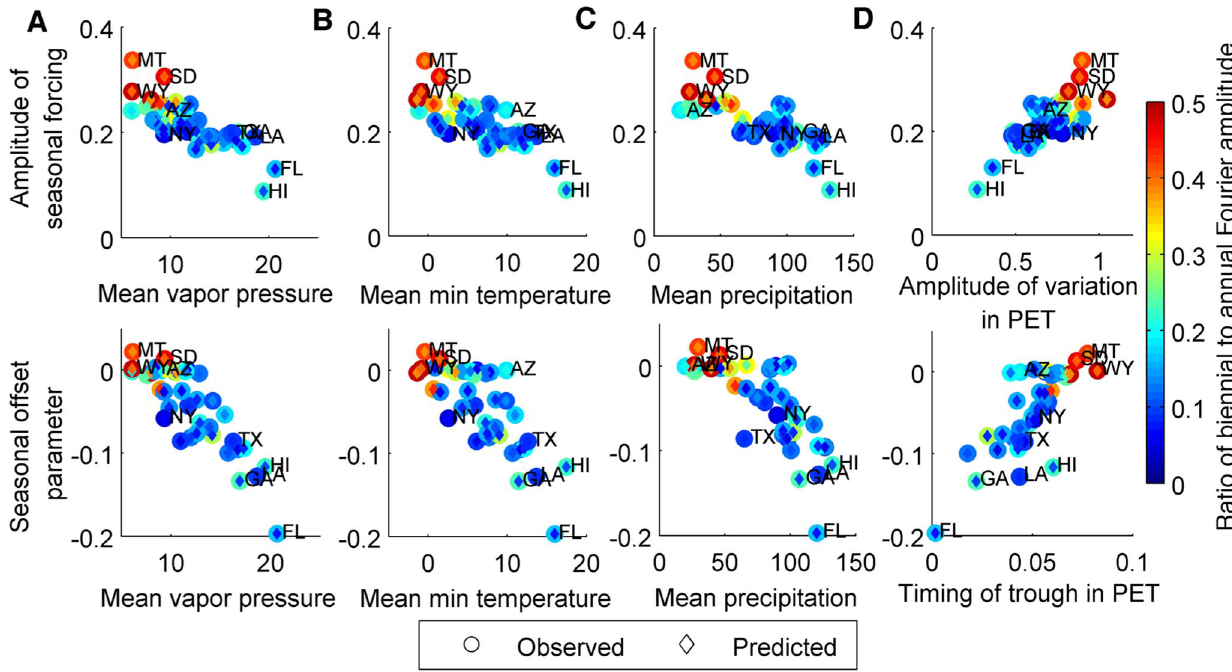
Fig. 3. Relationship between estimated seasonality parameters for model fit to laboratory report data and select climatic factors. The estimated amplitude of seasonal forcing in RSV transmission (top) and the estimated seasonal offset parameter (bottom: Q =0 represents January 1 and Q = 2 0.2 represents October 19) is plotted against ( A ) annual mean vapor pressure (hecta-Pascals), ( B ) annual mean minimum temperature ( u C), ( C ) annual mean precipitation (mm/month), and ( D ) amplitude (relative to the annual mean) and timing of trough in potential evapotranspiration (PET; 0=January 1, 0.1=February 6). The colorbar on the right indicates the ratio of the biennial to annual Fourier amplitude for the observed data (outer circle) and fitted model (inner diamond). Select states are labeled: Arizona (AZ), Florida (FL), Georgia (GA), Hawaii (HI), Louisiana (LA), Montana (MT), New York (NY), South Dakota (SD), Texas (TX), Wyoming (WY).